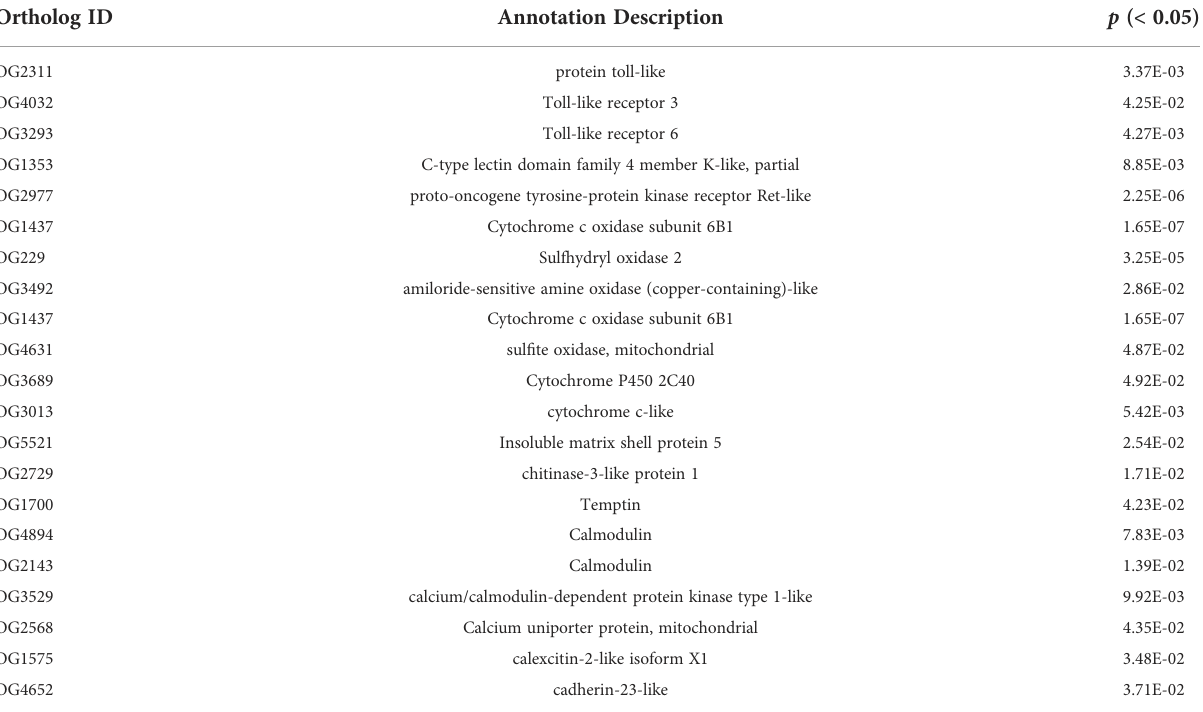
TABLE 2 Positively selected genes associated with stress